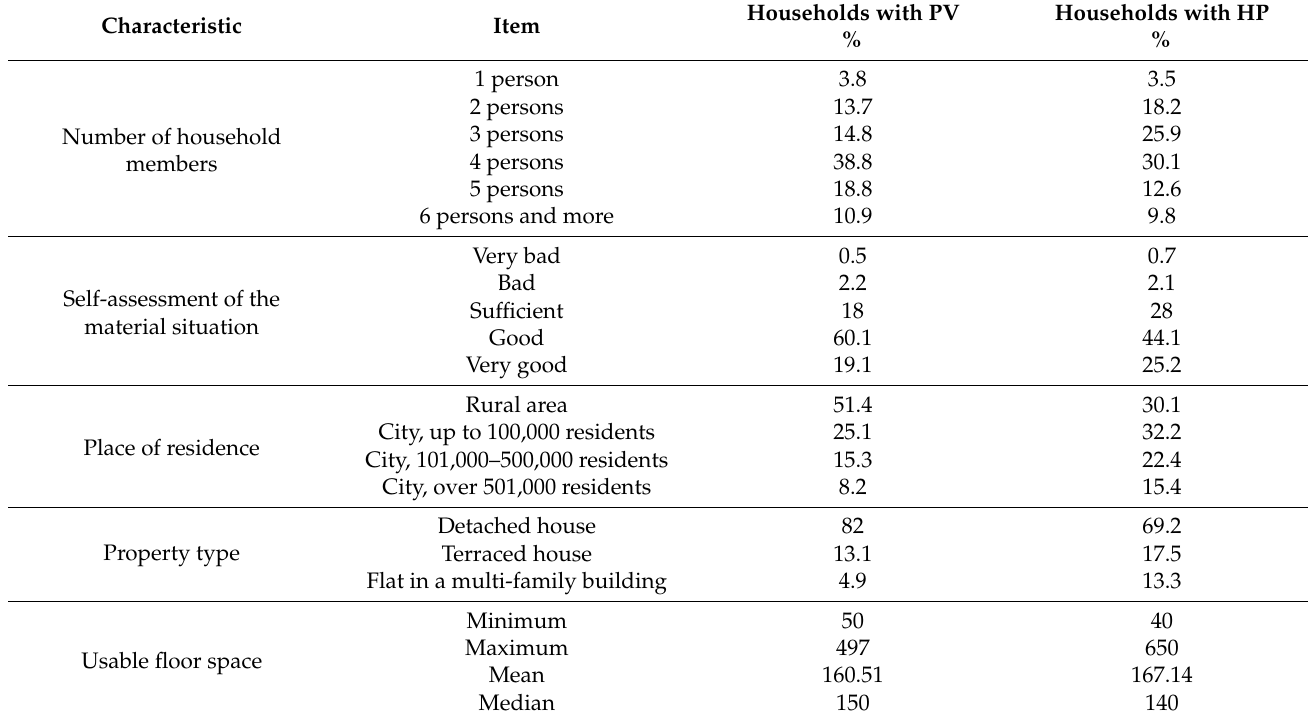
Table 1. Sample characteristics